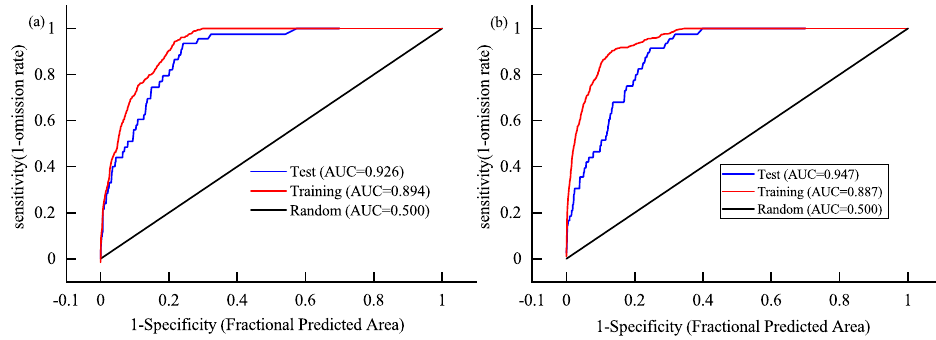
Figure 2. The receiver operating characteristic (ROC) curve of M C and M CS : ( a ) indicates the ROC curves of M C ; ( b ) indicates the ROC curves of M CS .